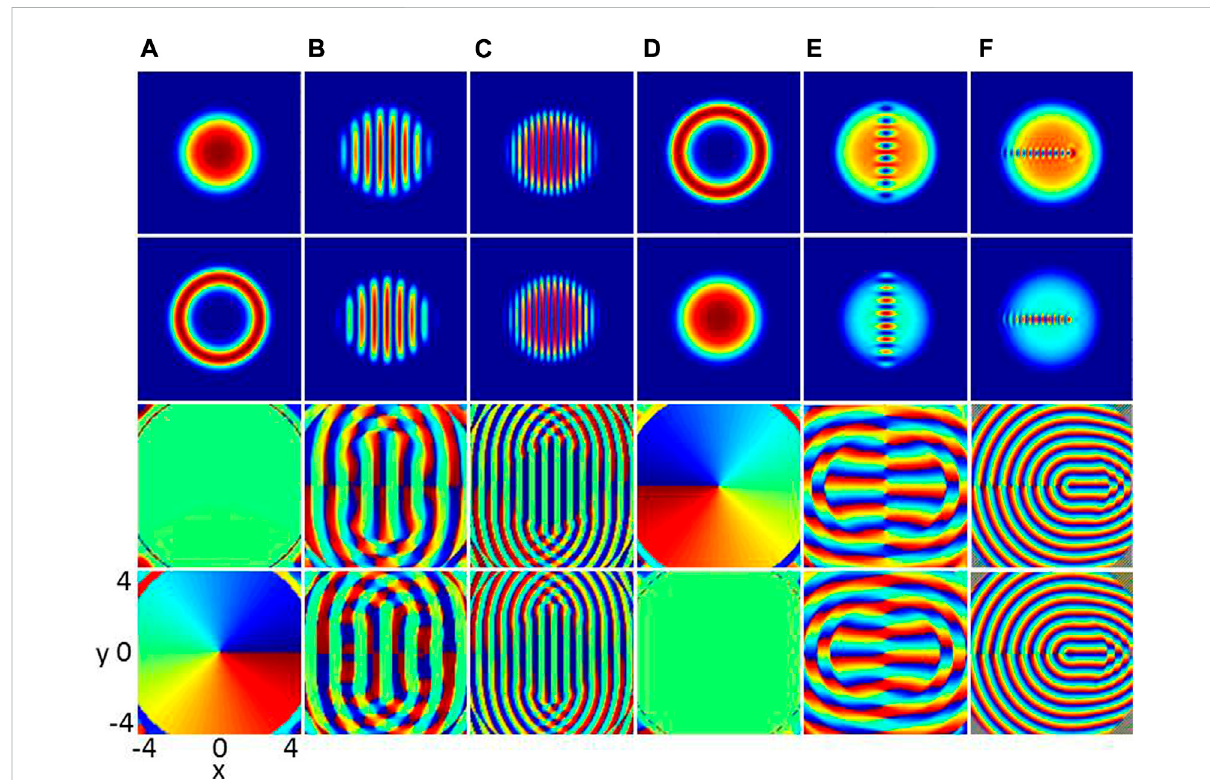
FIGURE 3 (Coloronline) Ground statesoftwo-componentBECs withdifferentDDIandD-SOCinananharmonic trap,where β 11 =50, β 22 =100and β 12 = 150, (A) ε dd =0.2, k =0.5, (B) ε dd = 0.2, k =5, (C) ε dd =0.2, k =9, (D) ε dd =5, k =0.5, (E) ε dd =5, k = 5,and (F) ε dd =5, k =9.The rowsfromtop tobottom denote |